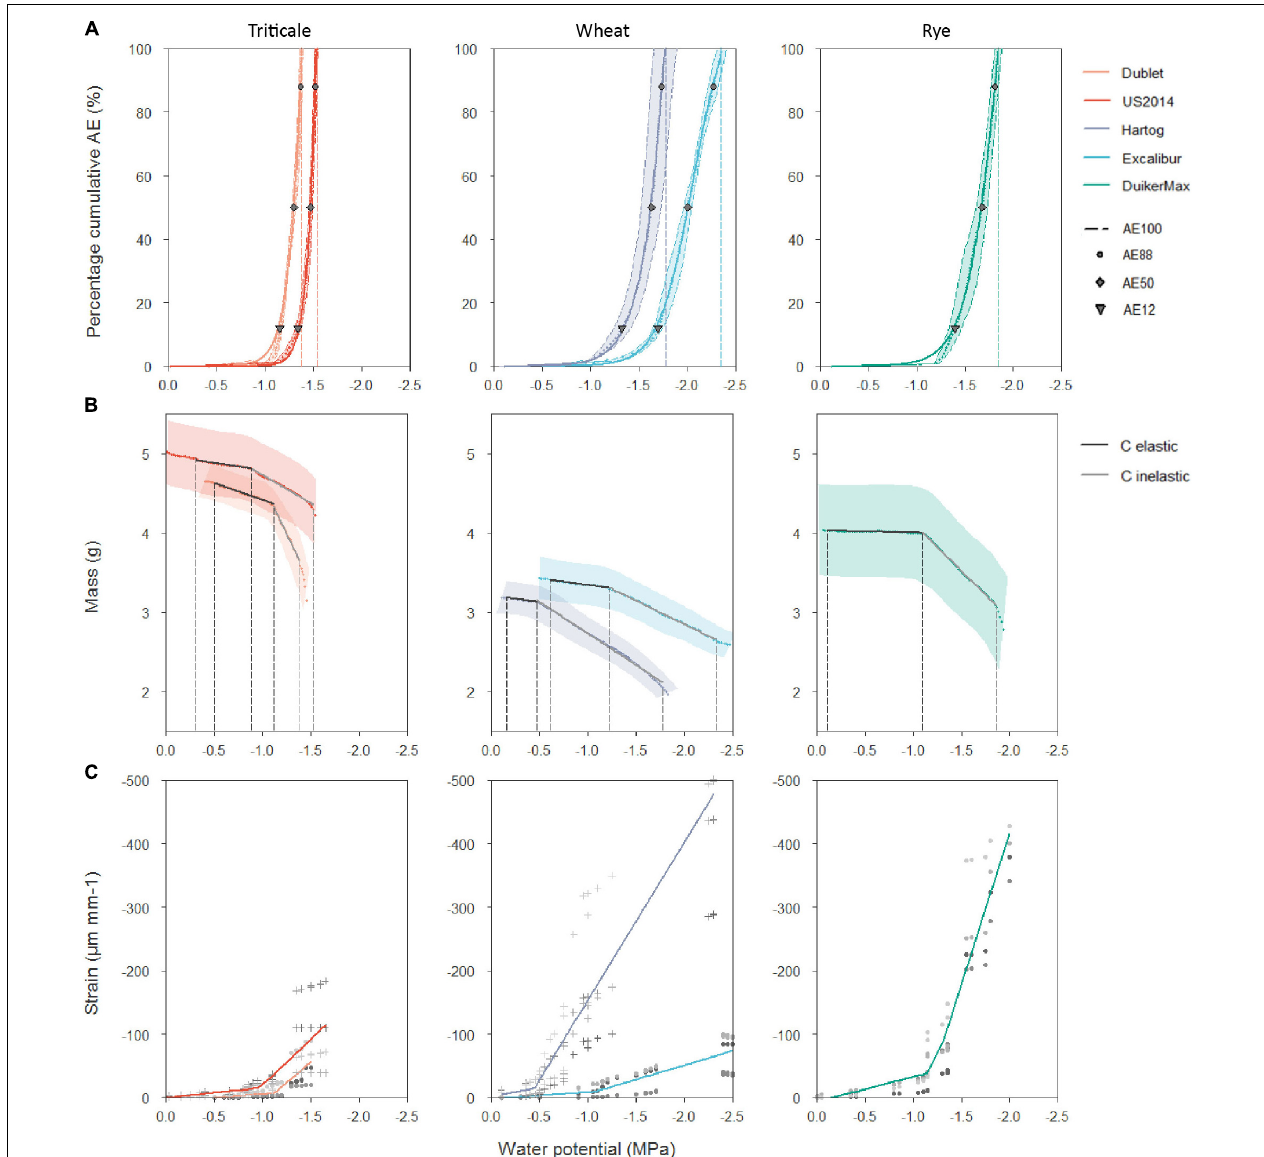
FIGURE 3 | (A) Averaged vulnerability curves (VCAEs) with standard error bands of triticale cultivars Dublet and US2014, wheat cultivars Hartog and Excalibur and rye cultivar Duiker Max. AE 12 , AE 50 , AE 88 , and AE 100 are indicated. (B) Averaged desorption curves (DCs) with standard error bands for the same cultivars. Elastic and inelastic shrinkage are delimited by vertical dashed lines, and the corresponding hydraulic capacitances (C, g MPa − 1 ) of both phases are calculated as the slope of the linear regressions. (C) General stress–strain relationship for all five cultivars. The different shade colors for or + indicate the different shoots for each